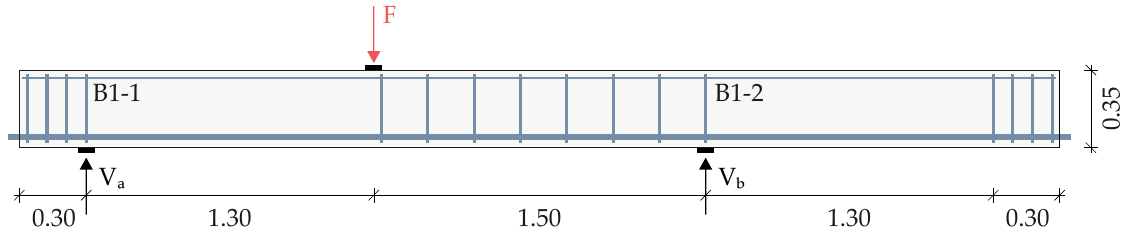
Figure 2. Side view of test specimen B1, including the reinforcement arrangement. A normal-strength concrete with a maximum aggregate size d g = 16 mm was used. At the day of testing, the properties of the hardened concrete were identified in the ma- terial tests summarized in Table 1. The concrete compressive strength was determined on 150-mm cubes ( f cm,cube ) and on concrete cylinders with d / h = 150/300 mm ( f cm,cyl ), according to reference [39]. The splitting tensile strength ( f ct,sp ) was tested on shortened cylinders ( d / h = 150/150 mm). The mean modulus of elasticity ( E cm ) was also tested on cylinders ( d / h = 150/300) with method “B”, according to reference [40]. Table 1. Material properties of the hardened concrete at the day of testing. Test No.